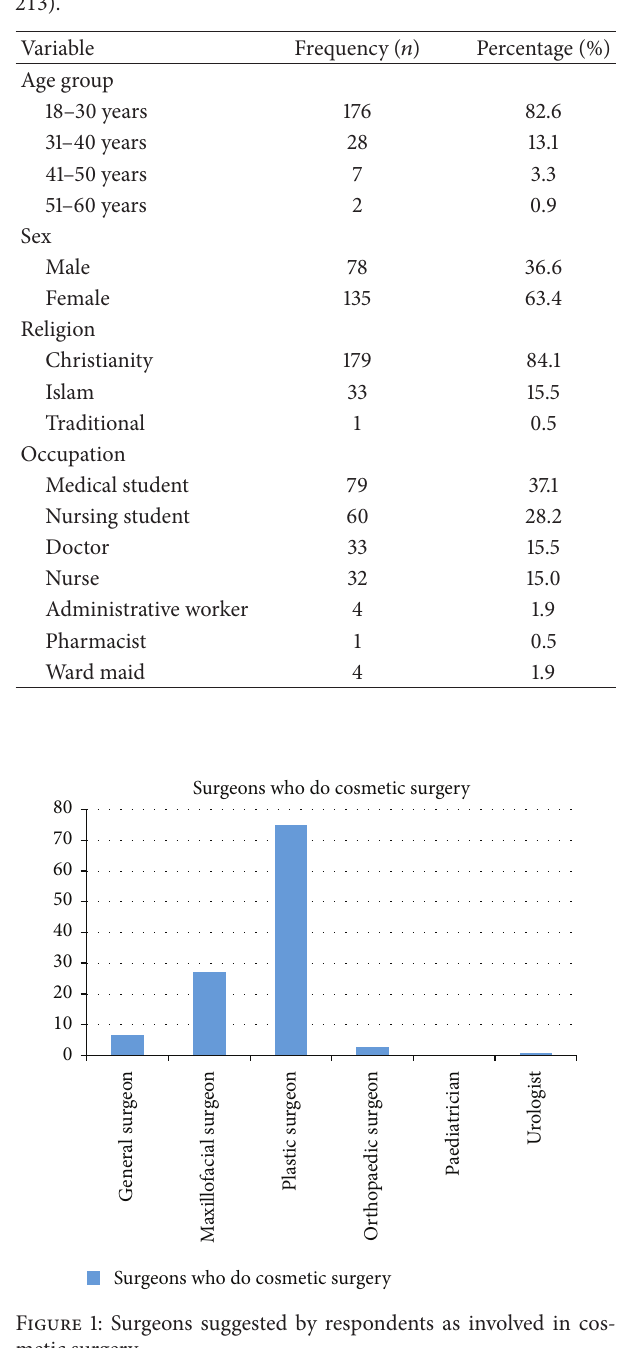
Table 1: Distributions of respondents’ sociodemographic data ( 𝑛 = 213 ).